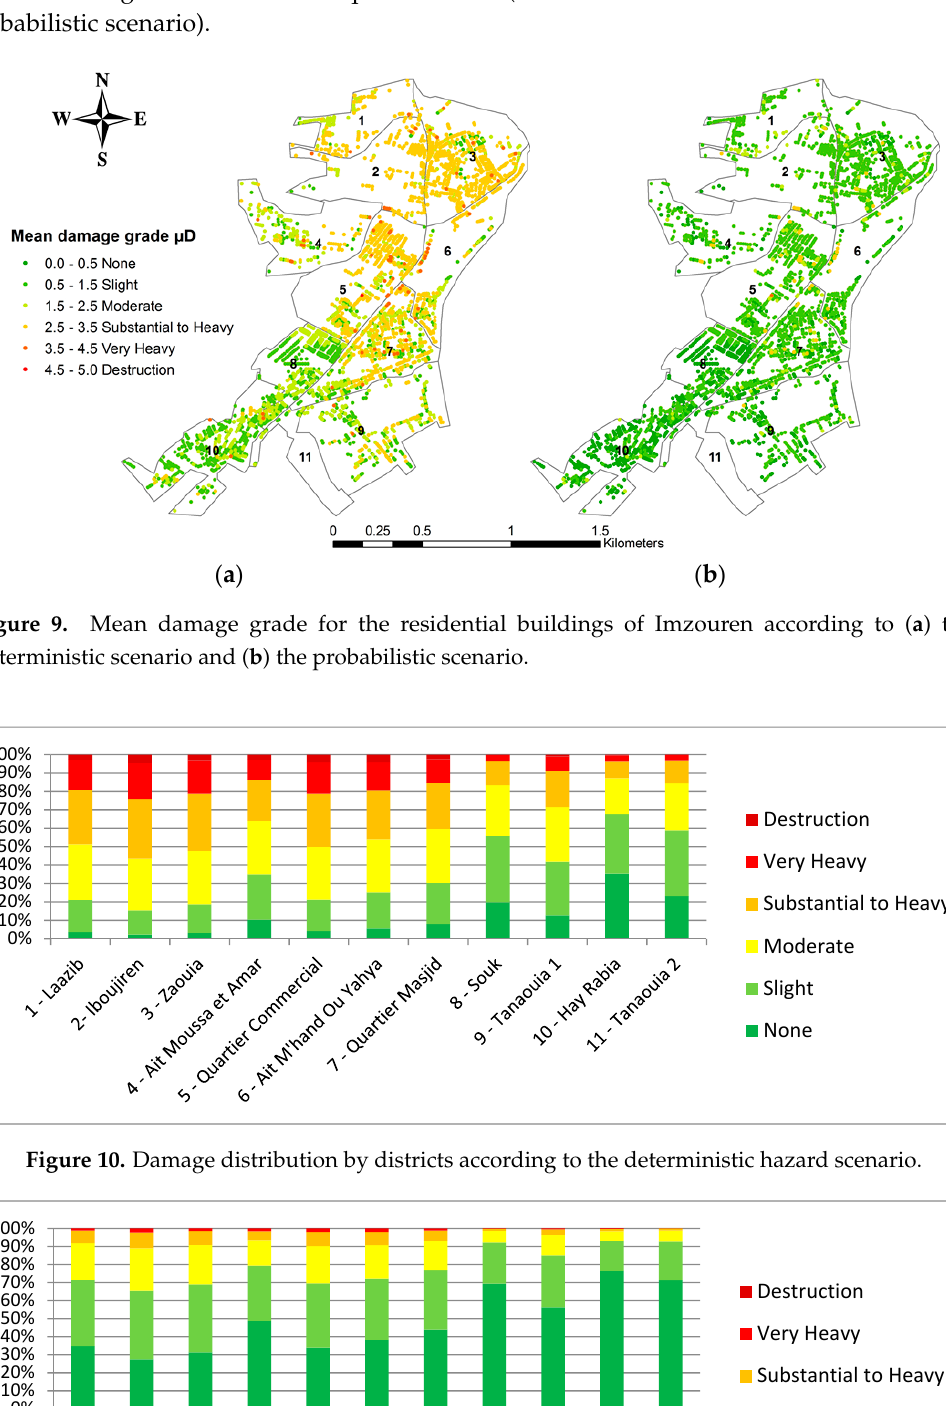
Figure 10. Damage distribution by districts according to the deterministic hazard scenario.